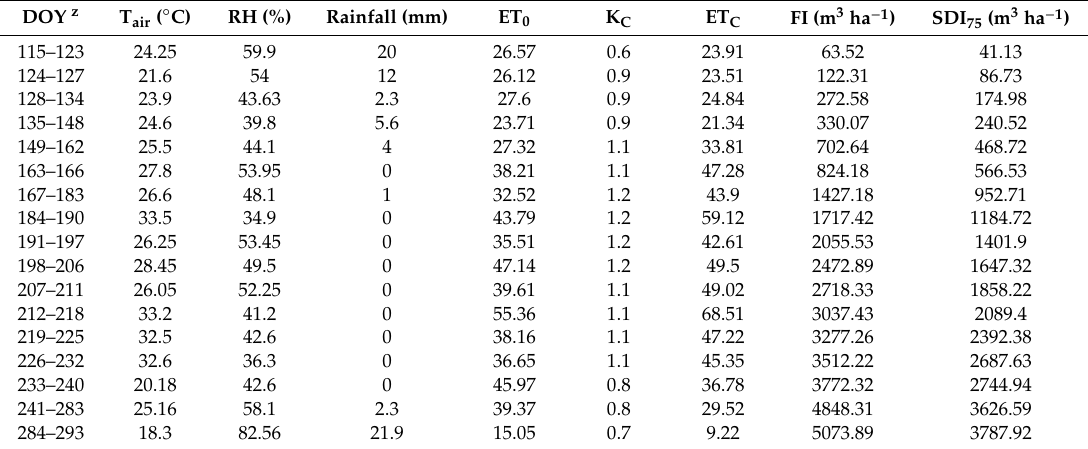
Table 1. Climatic conditions, water requirements, and irrigation doses applied during the season. DOY z T air (°C)